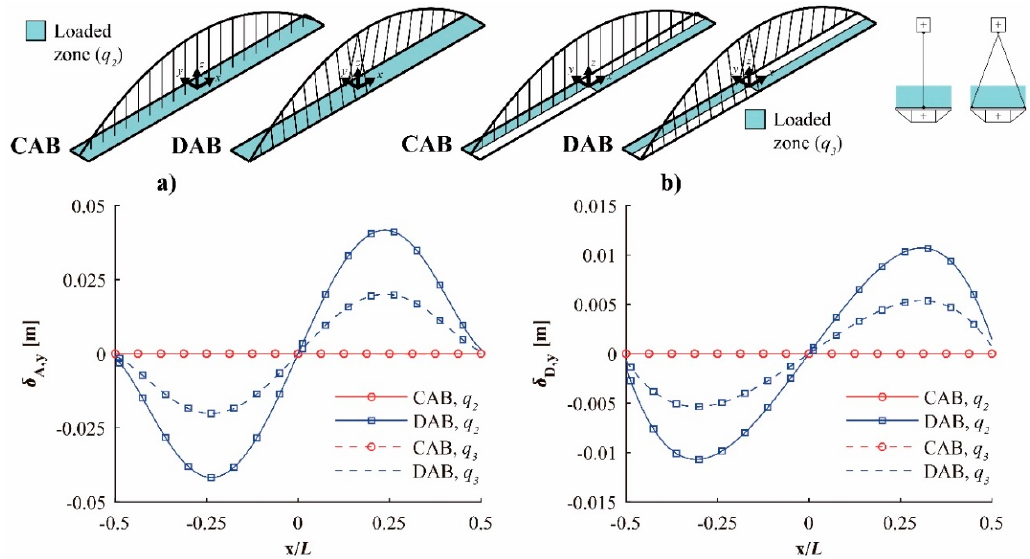
Figure 34. Transversal deflections at the arch ( a ) and the deck ( b ) under q 2 and q 3 for the CAB and DAB.